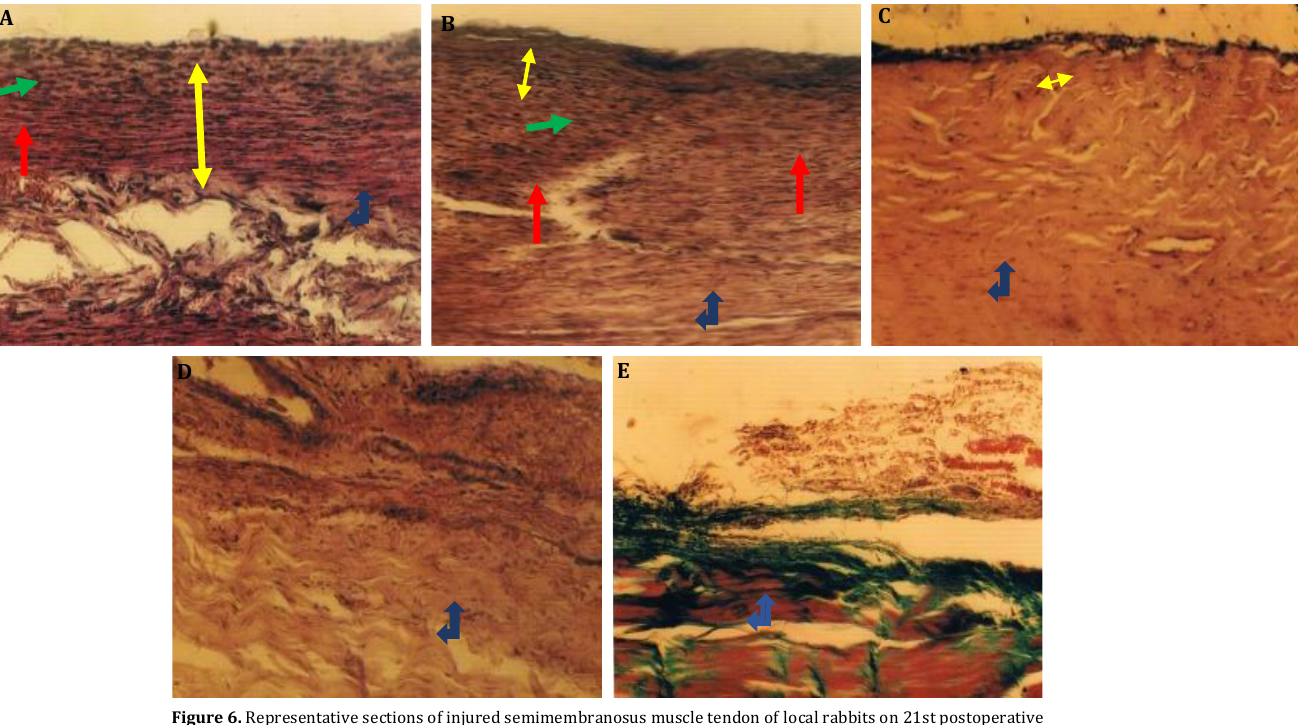
Figure 6. Representative sections of injured semimembranosus muscle tendon of local rabbits on 21st postoperative day in (A) Control group showing thick epitenon (yellow double-arrow), inflammatory cells (green arrow) and fibroblasts infiltration (red arrow), and incoherent collagen fibers (blue left-up arrow), H&E, 20× ; (B) Group A , irradiated with diode impulse laser at 1800 rad for 15 min showing thinner epitenon (yellow double-arrow), longitudinal arranged fibroblasts (red arrows), and regular collagen (blue left-up arrow), H&E, 20× ; (C) Group B , irradiated with diode impulse laser at 3000 rad for 25 min showing thin peritenon (yellow double-arrow) and wavy shape collagen fibers (blue left-up arrow), H&E, 10×; (D) Group D , irradiated with diode impulse laser at 4200 rad for 35 min showing regular dense collagen deposition blue left-up arrow), H&E, 20×; (E) Group E , irradiated with continuous diode laser at 5400 rad for 30 min showing dense, regular, and wavy collagen fibers (blue left-up arrow) green in color (Masson's